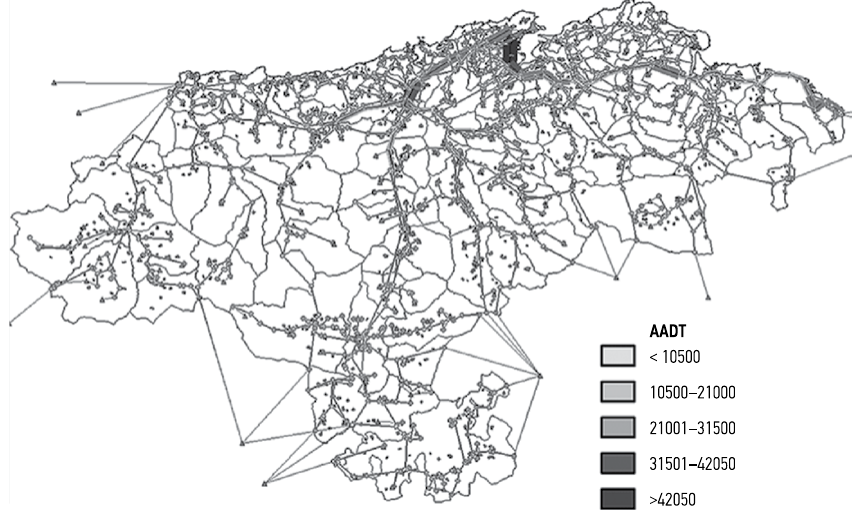
Fig. 6. Assignment of traffic to the